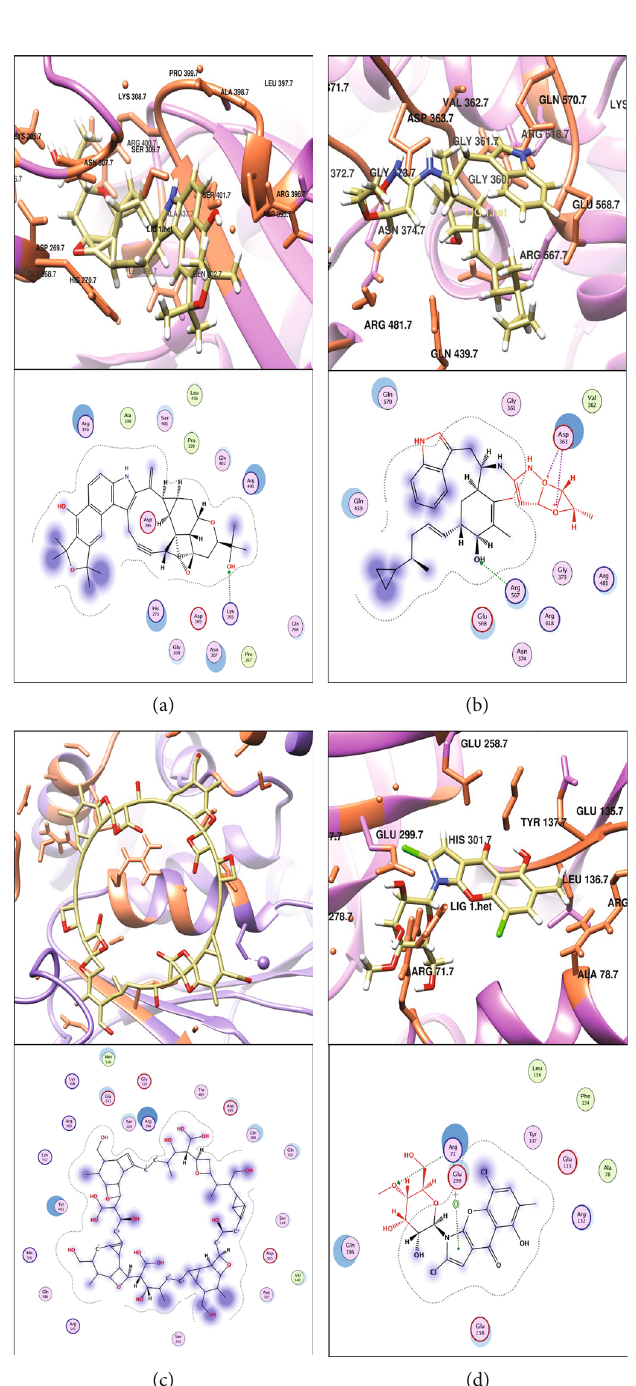
Figure 4: Docking studies of: (a) NPA000018 (Lolicine A); (b) NPA000111 (Armochaetoglobin N); (c) NPA000305 (Quartromicin D2); and (d) NPA014826 (Pyralomicin 2b) generated through the Molecular Operating Environment (MOE) tool version (MOE_2016.0802) [43].